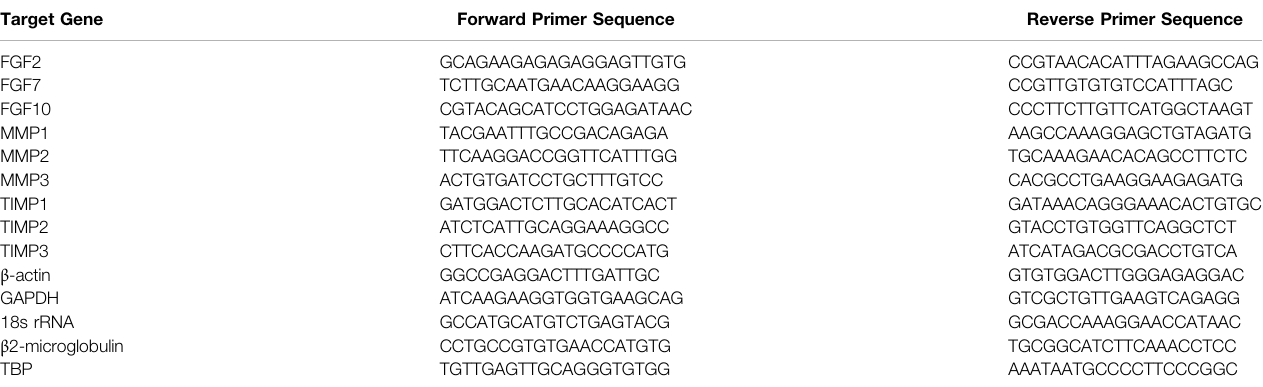
TABLE 1 | Sequences of human primers used for real-time